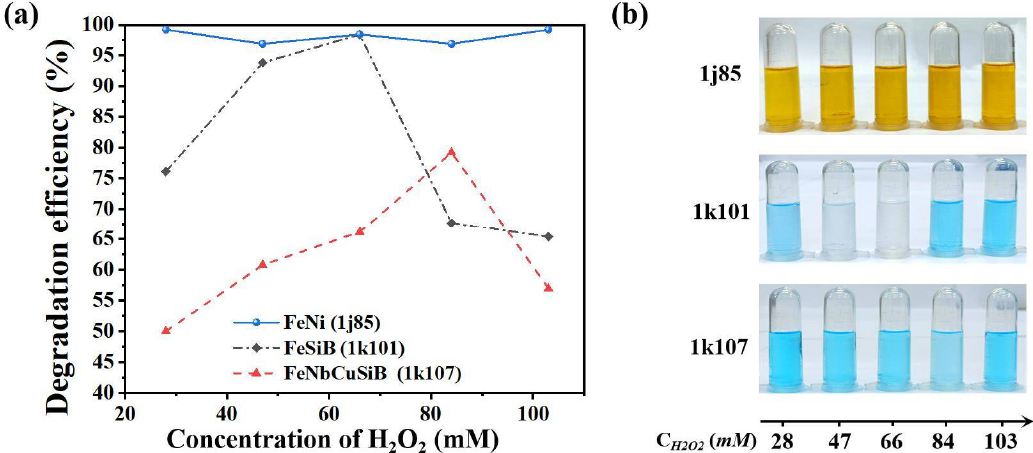
Figure 4. The MB degradation under different concentrations of H 2 O 2 by using the microreactors with different Fe-based sheets; ( a ) the degradation efficiency; ( b ) The degraded MB solution sam-